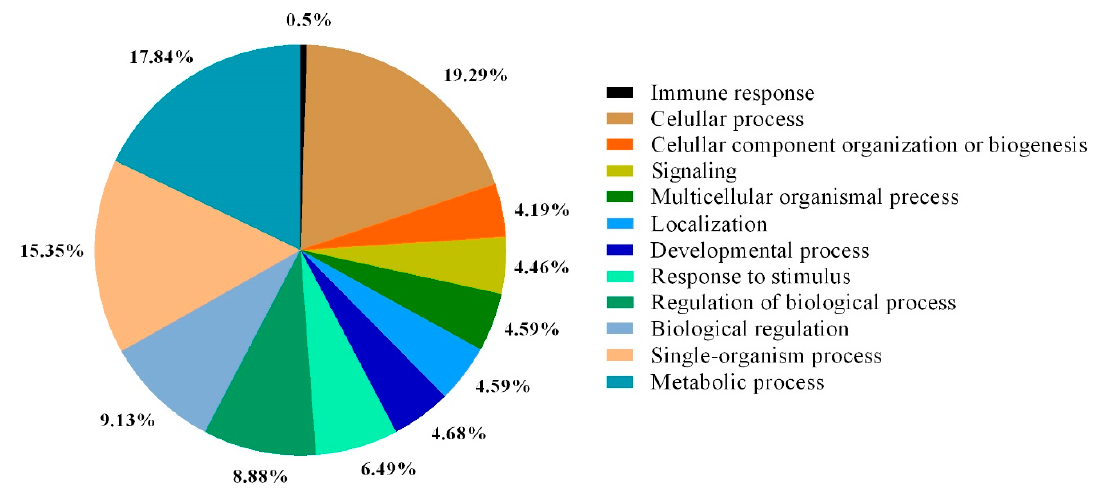
Figure 1. Functional Gene Ontology annotation of the Eleginops maclovinus head kidney transcriptome revealed transcripts involved in biological processes.